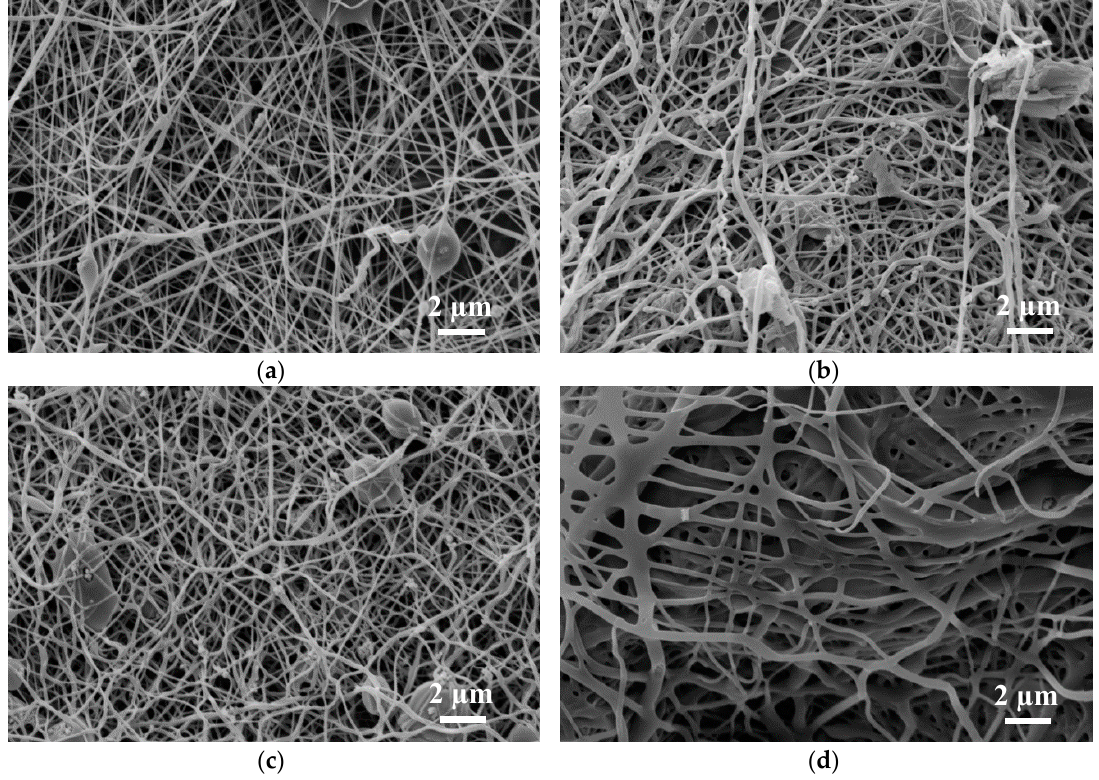
Figure 2. SEM images of polyacrylonitrile (PAN)/magnetite nanofiber mats: ( a ) after electrospinning; ( b ) after stabilization; ( c ) after carbonization at 500 °C; ( d ) after carbonization at 800 °C.